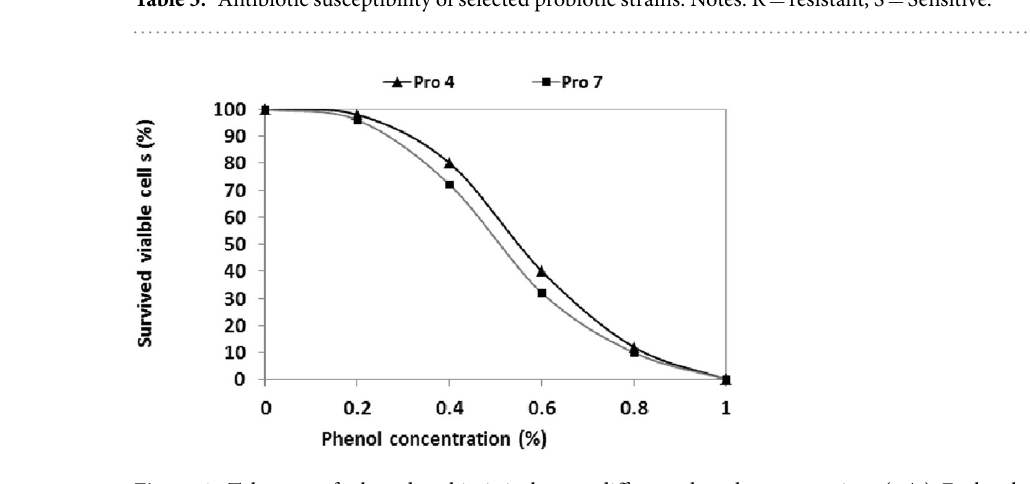
Figure 4. Tolerance of selected probiotic isolates to different phenol concentrations (w/v). Each value represents mean of sample ± SD for n = 3.